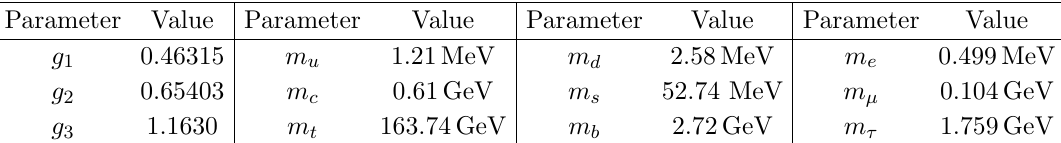
Table 1 . The values of the SM parameters, in MS scheme, at renormalization scale M t used in our analysis. More details are given in appendix